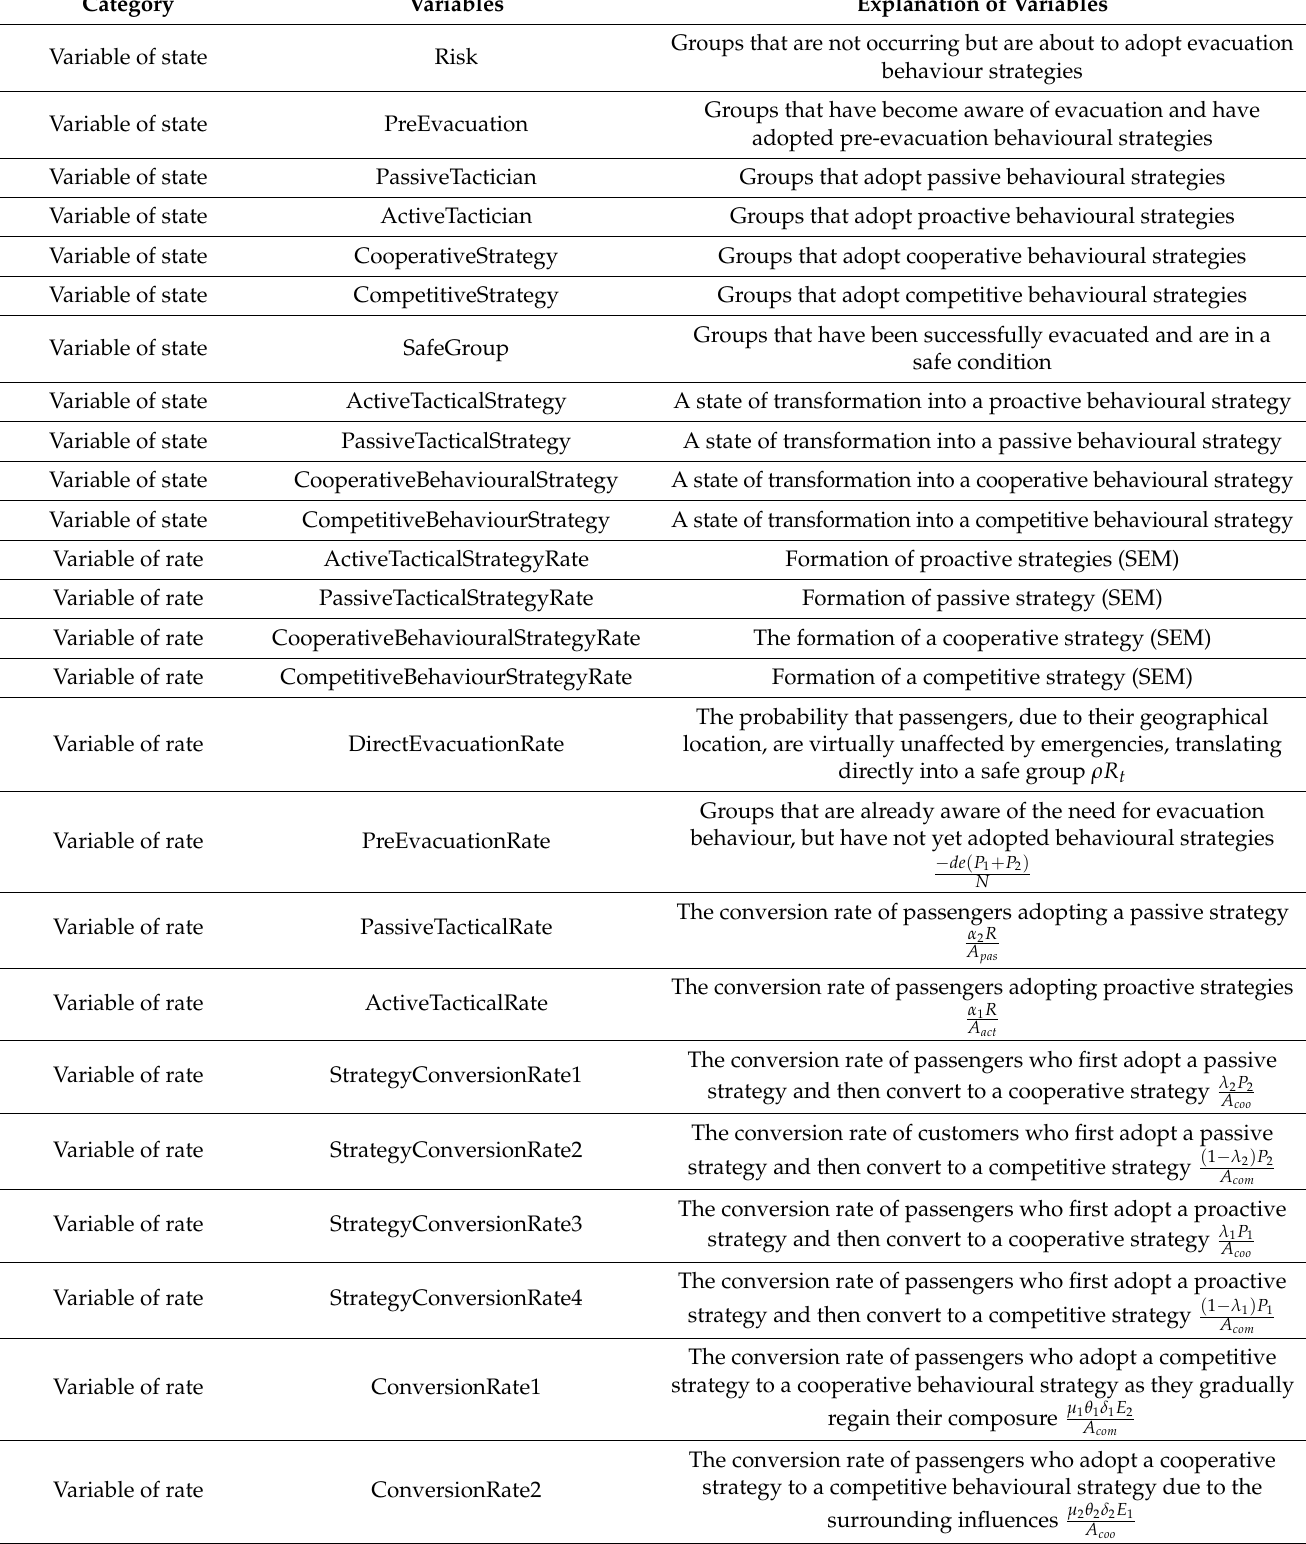
Table A1. Description of the main simulation